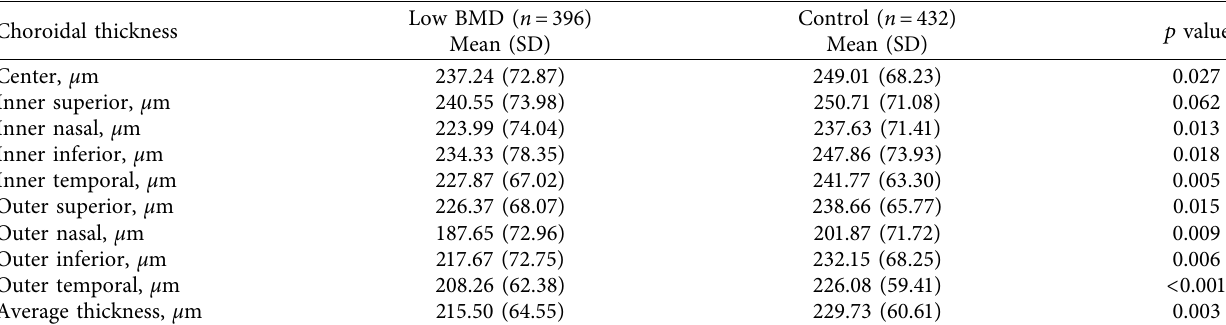
Table 2: The choroidal thickness of nine sectors of the ETDRS grid in the low BMD compared with the controls. Choroidal thickness